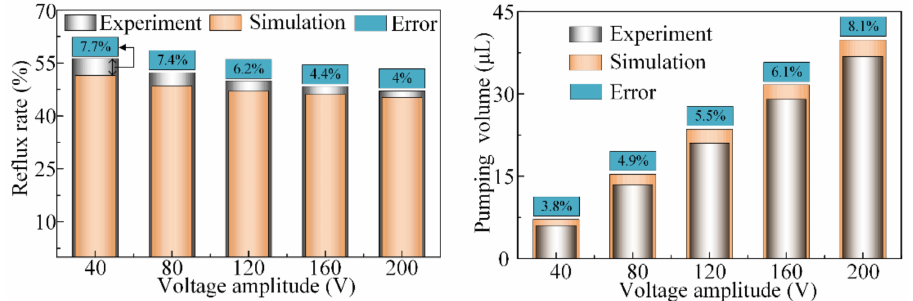
Figure 12. Test reflux rates and pumping volumes when applying differing voltage